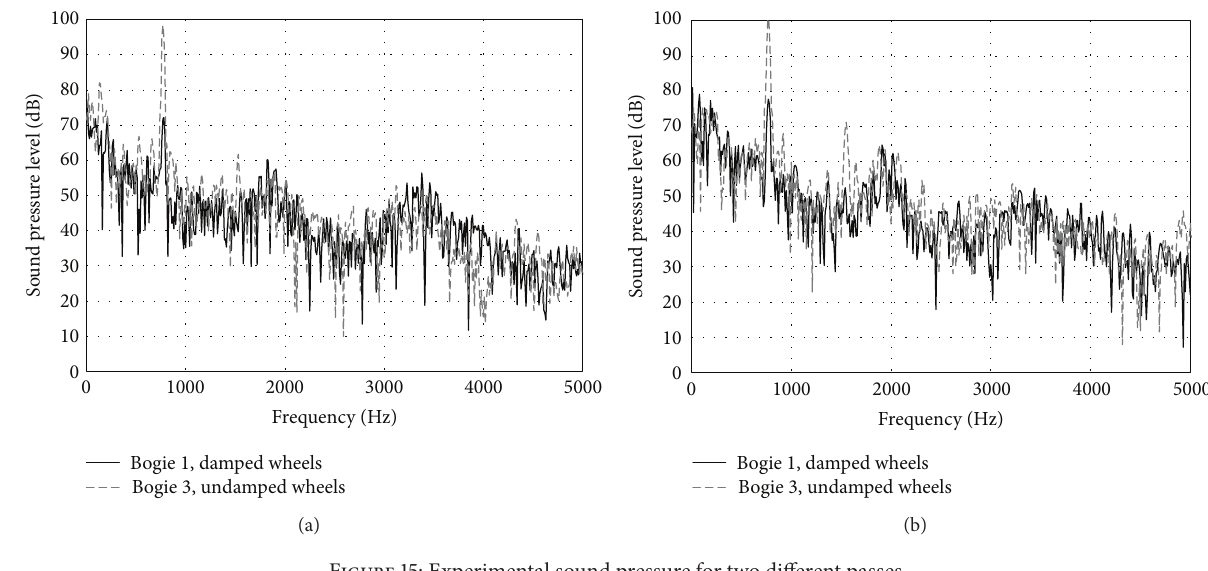
Figure 15: Experimental sound pressure for two different